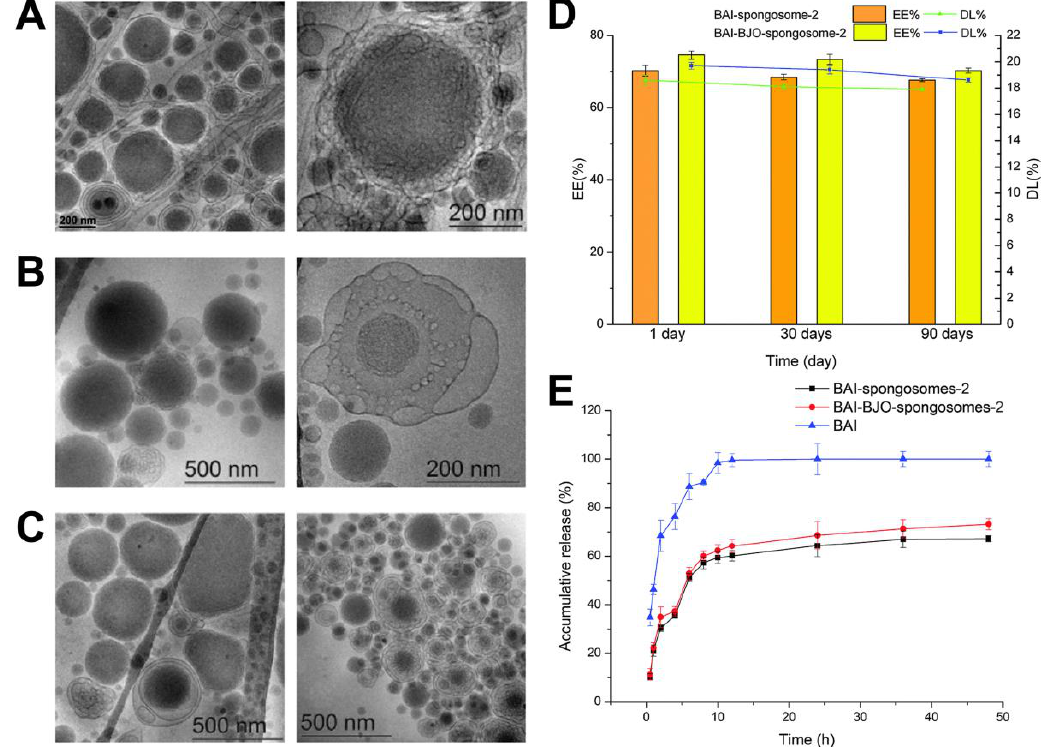
Figure 6. Cryo-TEM images are presented for spongosomes ( A ) without baicalin (BAI) or Brucea javanica oil (BJO), ( B ) with BAI only, and ( C ) with BAI and BJO; ( D ) Encapsulation efficiency (EE) and drug-loading (DL) values of the spongosomes containing BAI only or both BAI and BJO after different storage time periods postfabrication; ( E ) In vitro release profiles of BAI in phosphate-buffered saline (PBS) for spongosomes containing BAI only or both BAI and BJO, as compared to free BAI. Adapted with permission from [80].